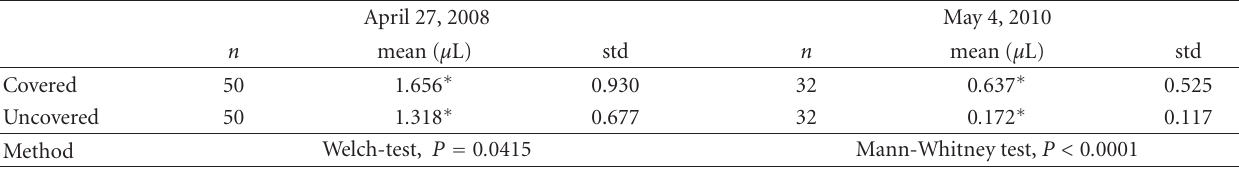
Table 3: The e ff ect of flower isolation on nectar volume at site 3.